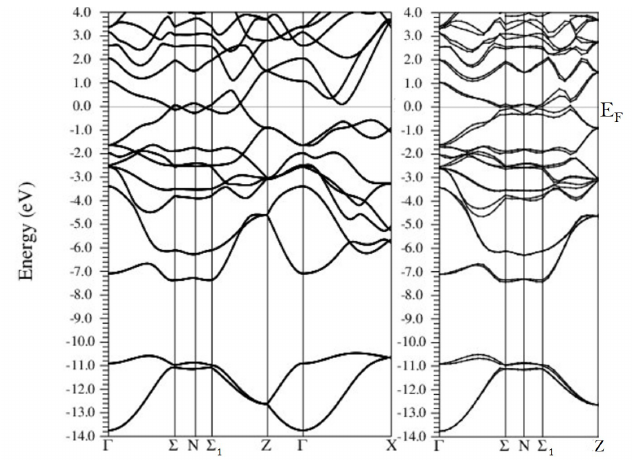
Figure 7. The band structure of TaP. The left panel does not include SOC; the right panel includes SOC. The electronic density of states plot shows a minimum value at the Fermi level. The